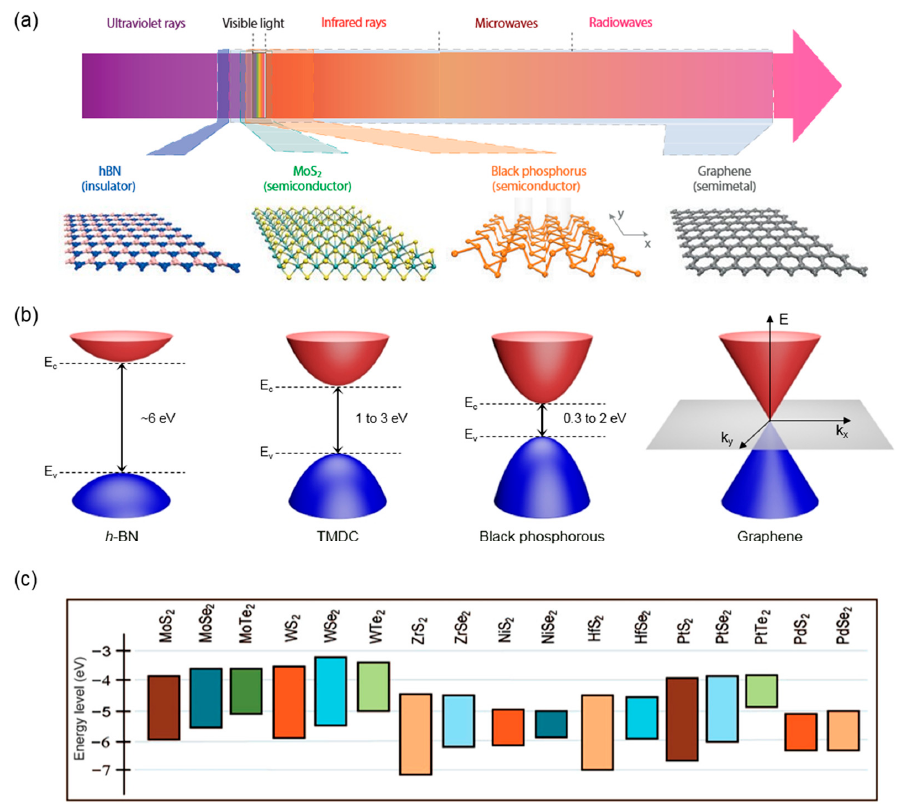
Figure 1. ( a ) Energy spectrum of various two ‐ dimensional (2D) materials and their atomic crystal structures [27]; ( b ) electronic band structures of hexagonal boron nitride ( h ‐ BN), transition metal dichalcogenides (TMDCs), black phosphorous, and grapheme; and ( c ) energy level diagrams of the selected semiconducting TMDCs [6]. Reproduced with permission from [27] and [6]. Copyright Nature, 2014 and Copyright Wiley, 2015, respectively.